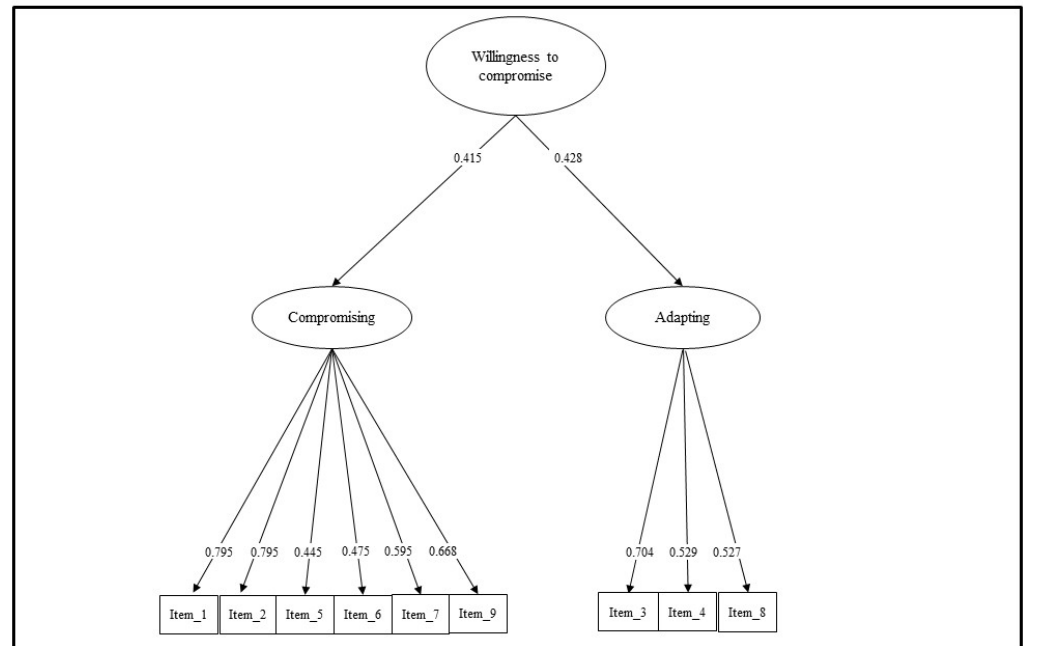
Figure 1. Second-order factor model. Table 1. Item descriptive statistics and confirmatory factor analysis.